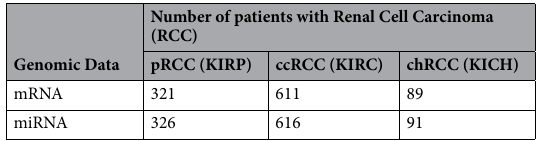
Table 1. Subtypes information of RCC in